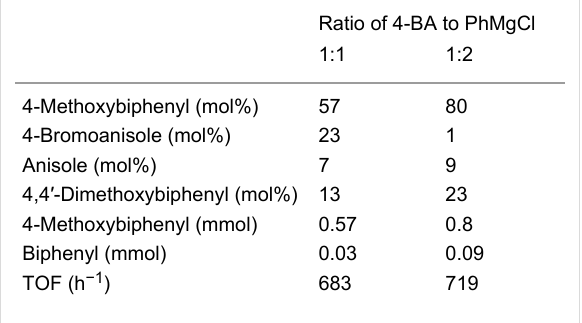
Table 1: Comparative study of aryl bromide to Grignard reagent ratio on product and by-product yields. Ratio of 4-BA to